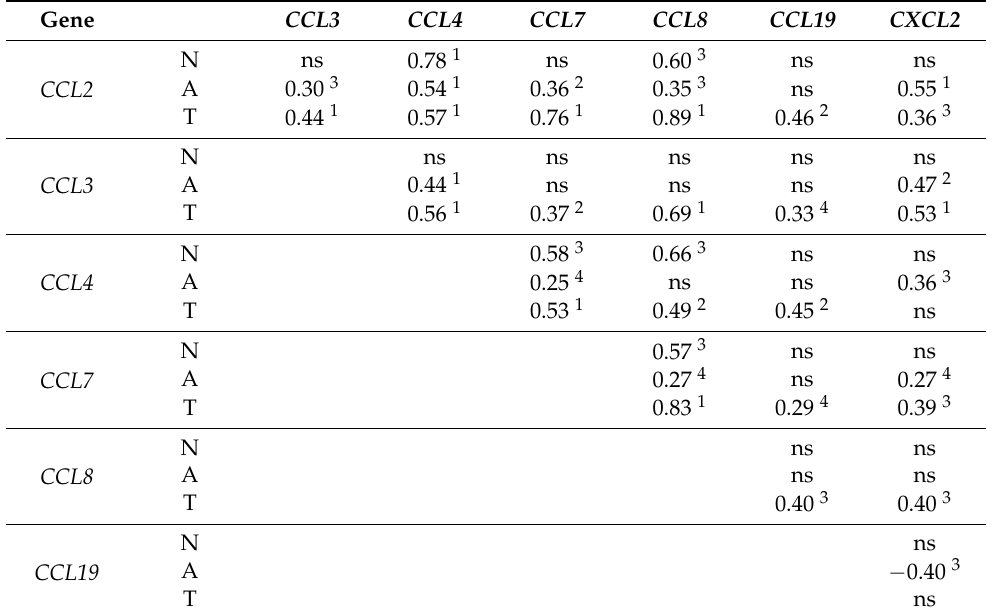
Figure 16. Impact of the depth of tumor invasion on the chemokine expression in tumors: ( a ) CCL2 ; ( b ) CCL3 ; ( c ) CCL7; ( d ) CCL8 . The data are presented as means with 95% confidence intervals, and as Spearman correlation coefficients ( ρ ). NRQ, normalized relative quantities. Table 2. Interrelationships between the expression of MCPs and